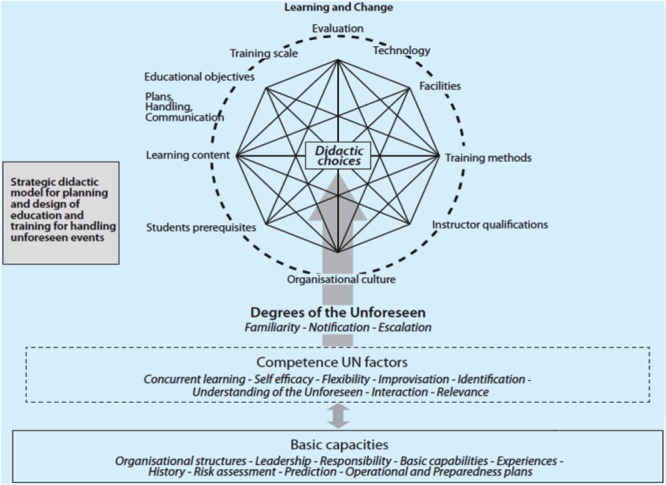
The Strategic Didactic Model for the Unforeseen (SD-UN) (modified after Torgersen, 2015, p. 330).